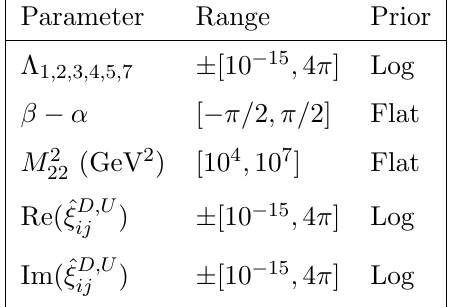
Table 6 . Parameters scanned over. We also indicate whether the priors are (cid:13)at or log. In the Yukawa sector, i; j = 2 ; 3, and all other couplings are